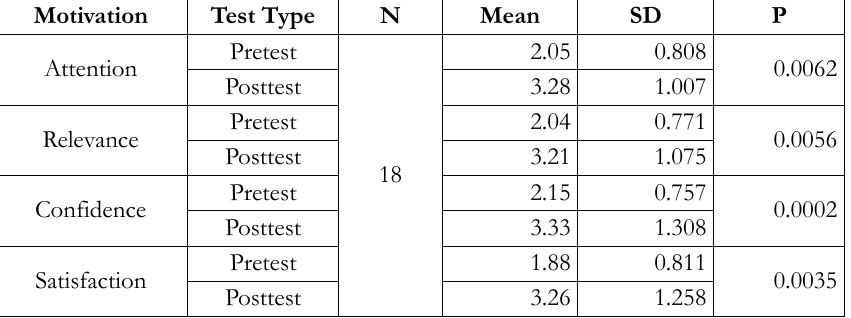
Table 6. MANOVA test of learners’